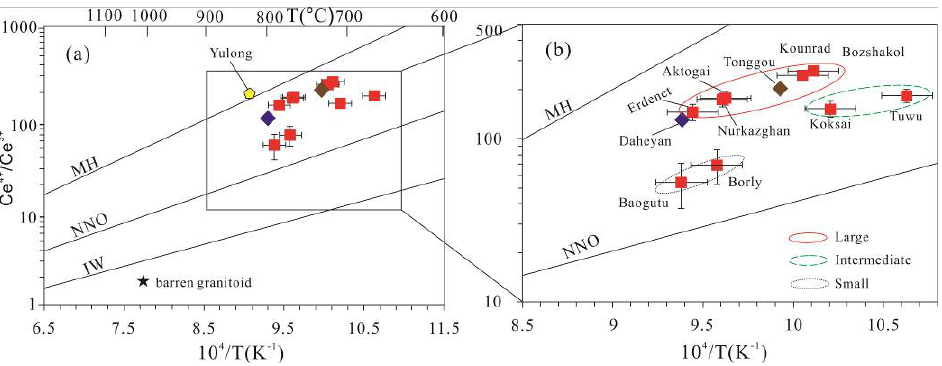
Figure 11. ( a ) Average Ce 4 + / Ce 3 + vs. 10 4 / T for porphyry Cu deposits of the CAOB; ( b ) amplifying average Figure 11. (a) Average Ce 4+ /Ce 3+ vs. 10 4 /T for porphyry Cu deposits of the CAOB; ( b ) amplifying Ce 4 + / Ce 3 + vs. 10 4 / T diagram. Temperatures were calculated using the Ti-in-zircon thermometer [73]. average Ce 4+ /Ce 3+ vs. 10 4 /T diagram. Temperatures were calculated using the Ti-in-zircon Partial data for porphyry Cu deposits of the CAOB cited from [30]. Curves for oxygen fugacity bu ff ers thermometer [73]. Partial data for porphyry Cu deposits of the CAOB cited from [30]. Curves for include magnetite–hematite (MH), Ni–Ni oxide (NNO), and Fe–wustite (IW) bu ff